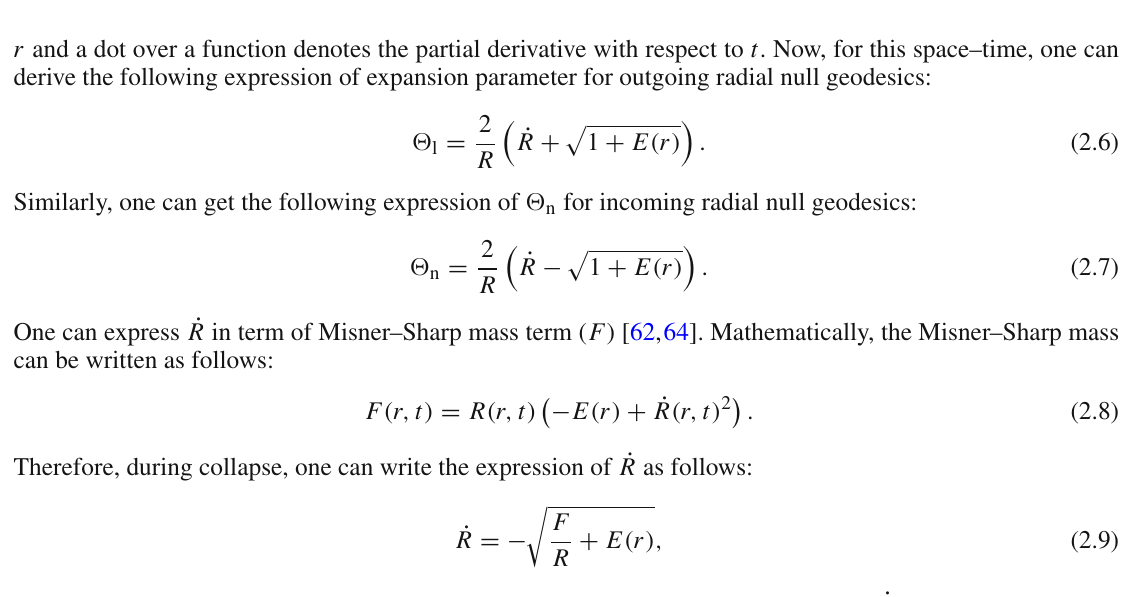
Fig. 1 a Here, light rays from the central singularity can escape the collapsing matter cloud before the apparent horizon formation, and they reach the asymptotic observer. Therefore, the central singularity can be visible for faraway observers. b Here, light rays fall into the apparent horizon before they reach the boundary of collapsing matter cloud. However, as these propagate inside the cloud, the singularity is locally visible. The picture is taken from